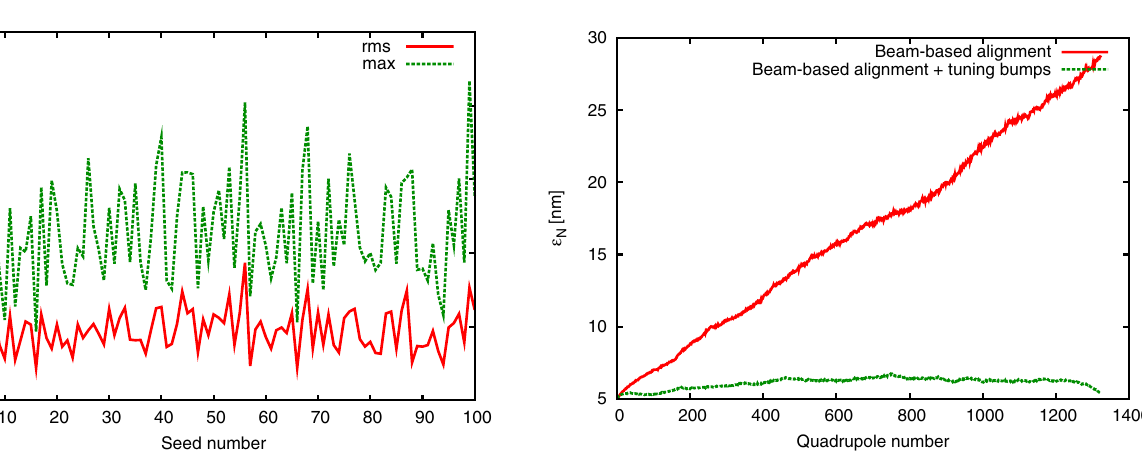
FIG. 21. Emittance along the CLIC main linac for beam-based alignment alone, compared to with the additional use of 10 optimal tuning knobs (after 20 optimization steps).